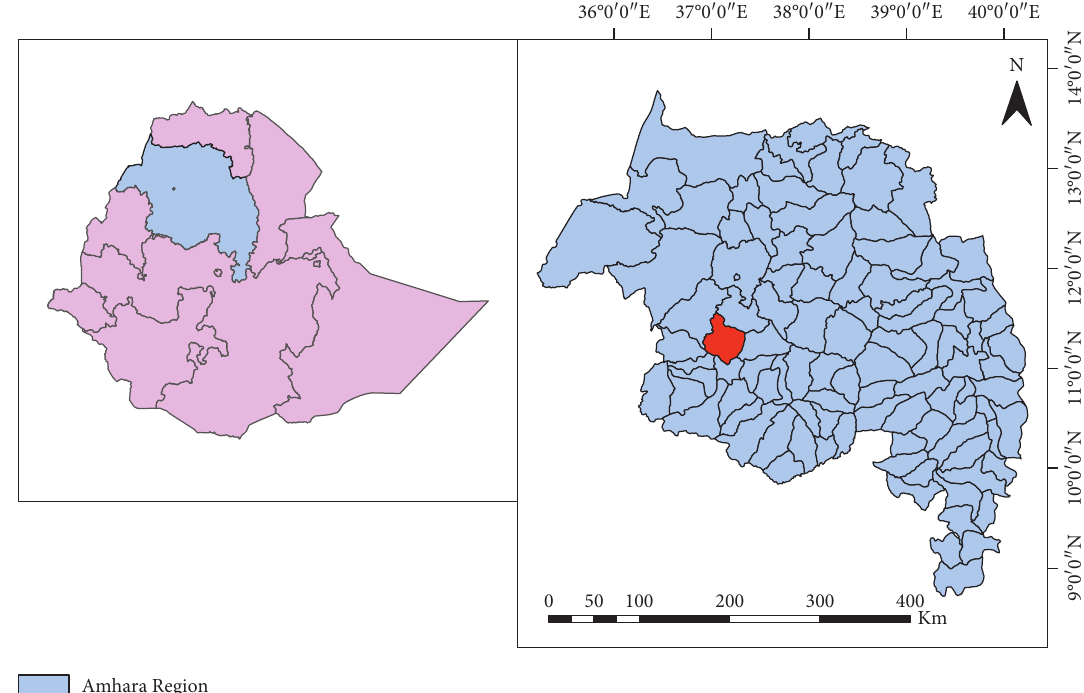
Figure 1: Map of the study area. Source: authors’ own compilation,